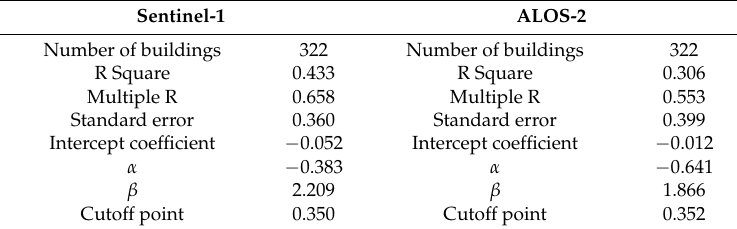
Table 2. Regression statistics of independent variables ( and ALOS-2